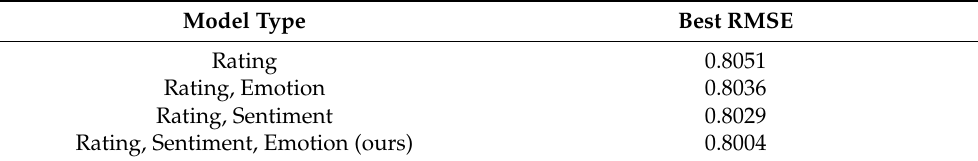
Table 3. RMSE Table for Cinematic Experience’s